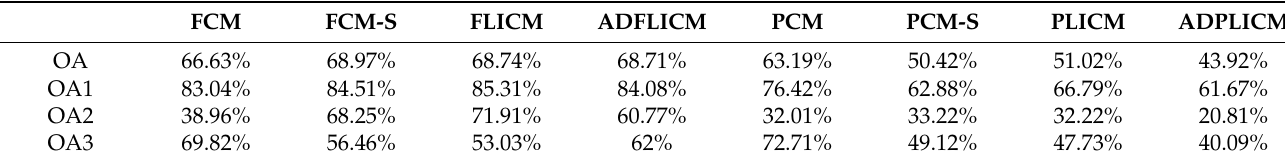
Table 2. The overall accuracy (in percentage) of FERM obtained from the conventional fuzzy classification algorithms and fuzzy local spatial information classification algorithms.